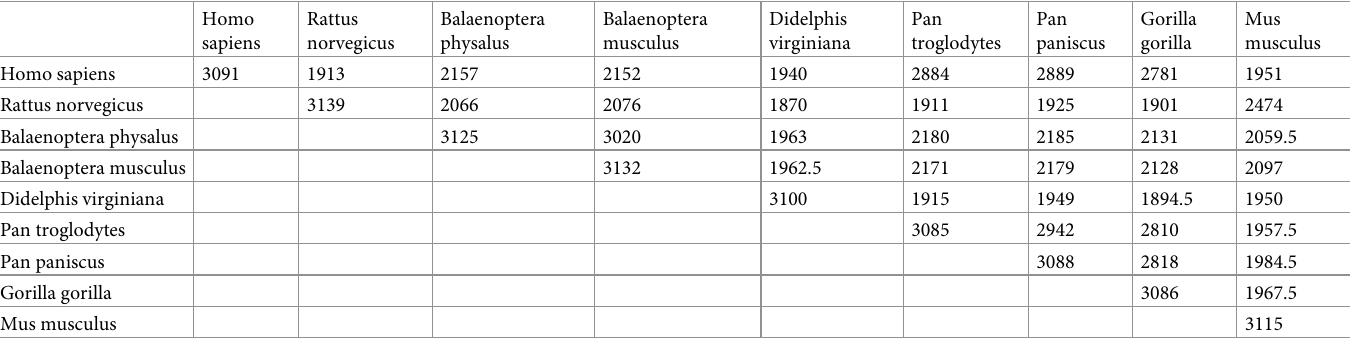
Table 6. The parameter Alignment Score of the Smith-Waterman algorithm in the quantitative measurement of homology. To calculate the Alignment Score of two compared sequences aligned by the HELIOS method, the BLOSUM62 substitution scoring matrix is adopted with gap opening and extension penalties equal to -10 and -0.5, respectively. Moreover, the “Nine ND5 protein sequences dataset” [53] is assumed in this